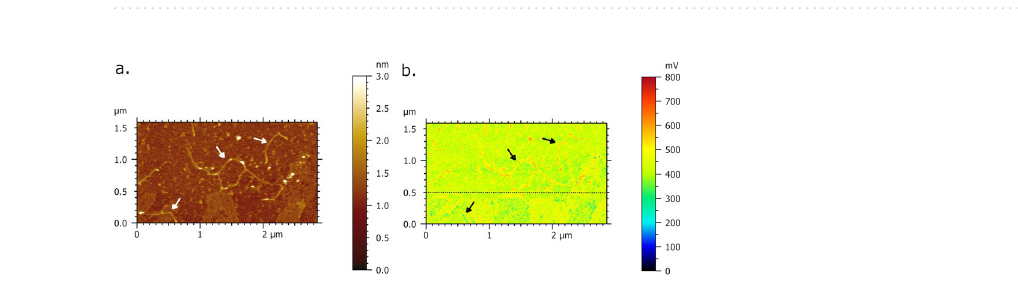
Figure 3. AFM-IR imaging of single DNA molecule deposited upon Ni 2+ pretreated mica surface. Size of imaged area: 1.0 × 1.0 µm. ( a ) AFM topography image of DNA and corresponding. ( b ) AFM-IR absorption map of single DNA recorded at optimized wavenumber 1633 cm −1 showing DNA of higher absorbance (bright red contour) regarding to mica surface. ( c ) AFM-IR spectra acquired and collected from two positions of DNA (two blue crosses in ( b )) showing prominent broadening peaks of amide bands with absorption maxima at 1618 cm −1 .